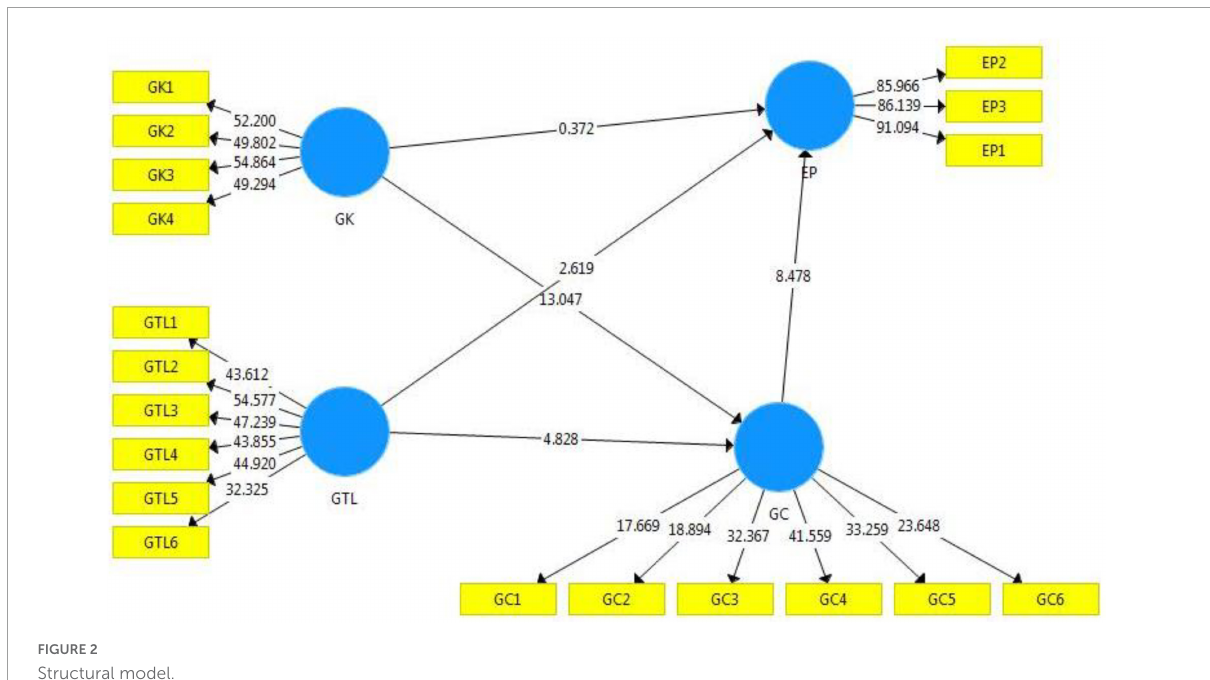
Figure 2 . As a final step, the predictive significance of the